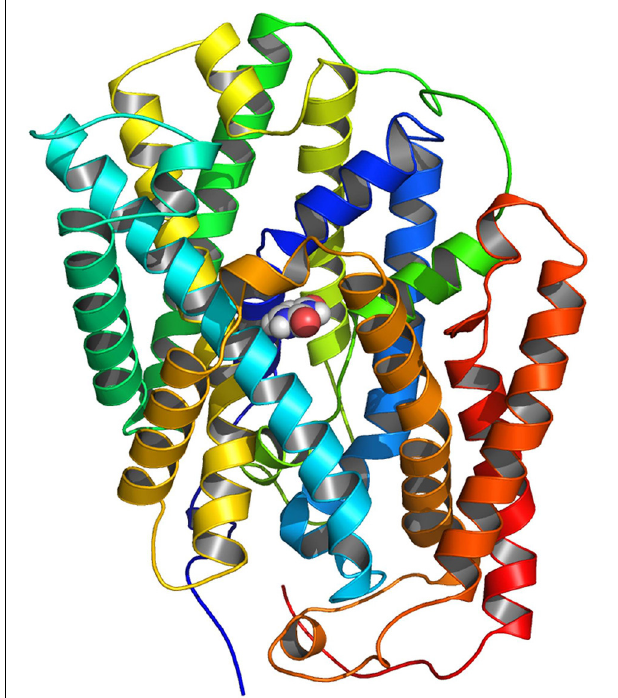
FIGURE 1 | Homology model of PLUTO, the plastidic nucleobase transporter from Arabidopsis with a uracil molecule located to the identified substrate binding site. Homology modeling was performed based on the outward open conformation of MHP1, the benzyl-hydanthoin transporter from Microbacterium liquefaciens . Reproduced from the model presented in Witz et al.